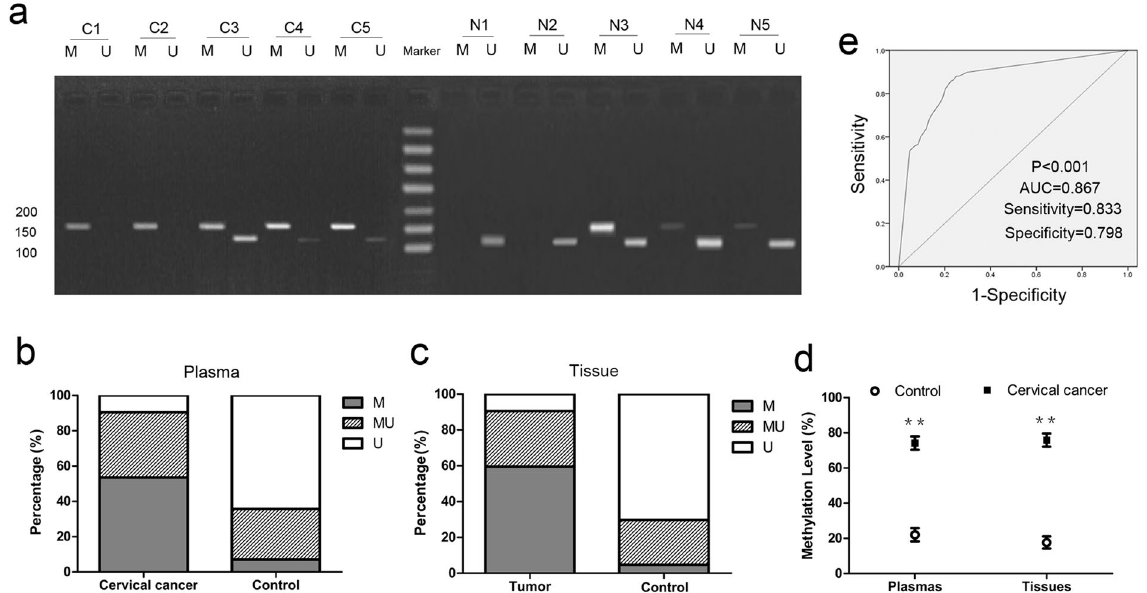
Figure 1. Analysis of methylation status of MEG3 promoter in plasmas and tissues using MSP. ( a ) MSP products illustrated that methylated pattern was largely detected in plasmas of cervical cancer patients (C1- C5 as examples) while unmethylated pattern was found in most of healthy participants’ plasmas (N1–N5 as examples). ( b ) The percentage of M, MU and U in plasmas of cervical cancer patients and healthy participants respectively. ( c ) The percentage of M, MU and U in cervical cancer tissues and adjacent normal tissues respectively. ( d ) The methylation level of MEG3 promoter in cervical cancer patients’ plasmas and cervical cancer tissues was significantly higher compared with their controls respectively. ( e ) ROC curve analysis for the diagnosis of cervical cancer by MEG3 methylation in plasma. MSP, methylation-specific polymerase chain reaction; M, methylated pattern; MU, partially methylated pattern; U, unmethylated pattern. ** P < 0.01.